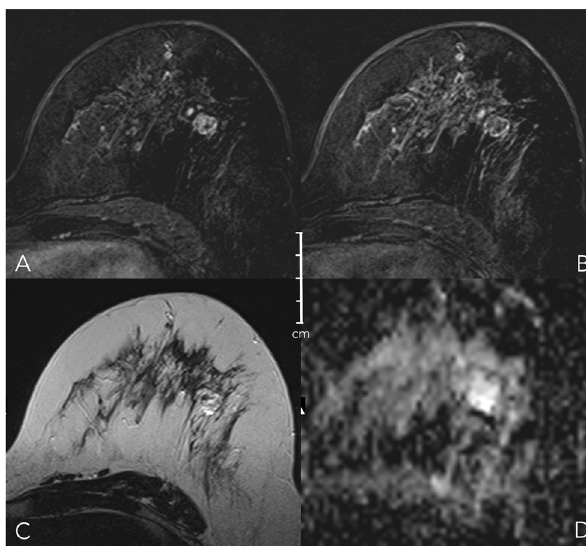
Fig. 13 Early (A) and delayed (B) contrast-enhanced subtractions, T2w (C), and ADC map (D). Mass lesion in the left breast of a 50-year-old female with several unclear mass lesions in both breasts; MRI obtained for treatment planning. The lesion shows no spiculations, a wash-out enhancement curve type, and a heterogeneous internal enhancement, corresponding to a Kaiser score of 8 (Fig. 6). Note high signal intensity on T2w. Due to high ADC (1.9*10 -3 mm 2 /s), the lesion was